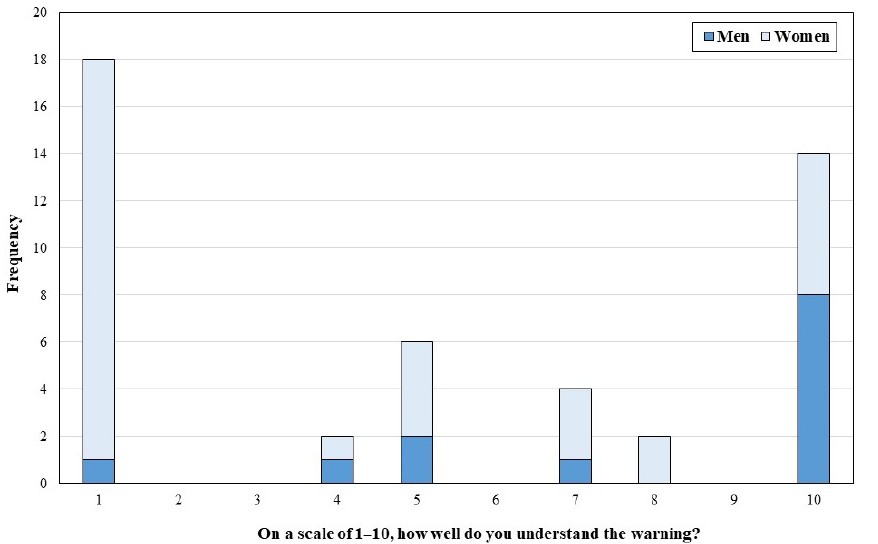
Figure 9. Number of responses to the question: “On a scale of 1–10, how well do you understand the warning”, divided by gender. Responses closer to 10 indicate better understanding.